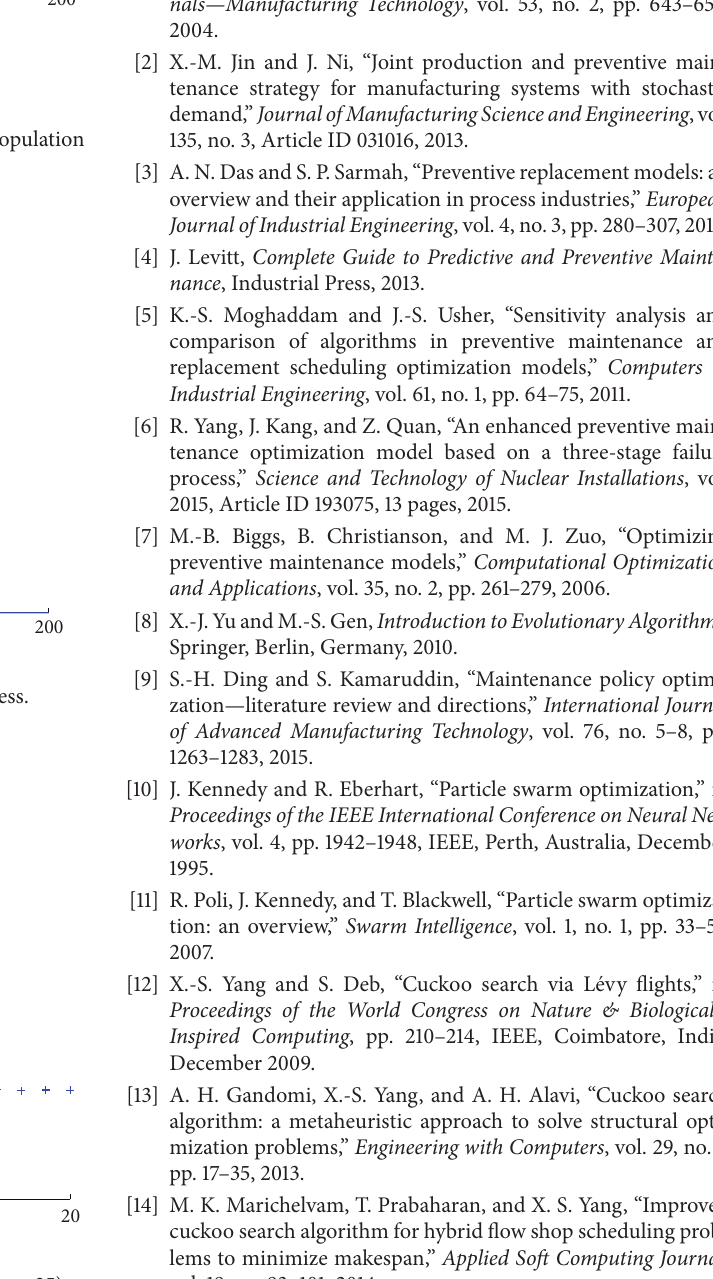
Figure 10: The optimal fitness of the population (sizepop =